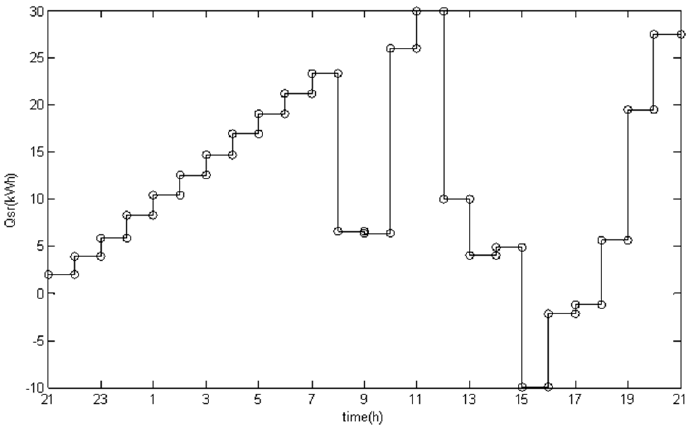
Figure 15. Output heat of the thermal storage.